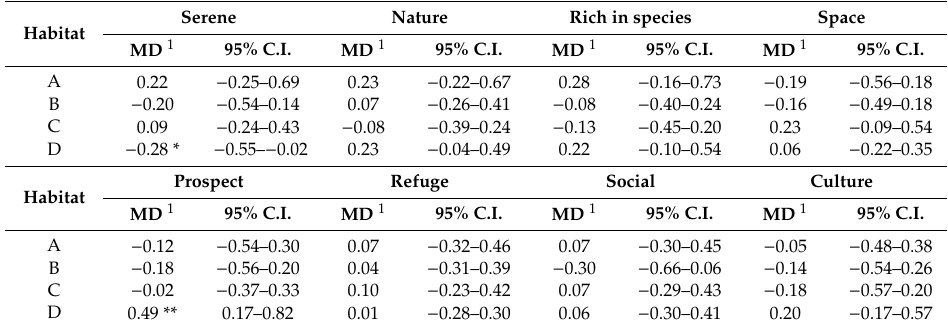
Table 2. Results from independent sample T test between the impacts of two stress level groups on the perception of eight sensory dimensions in each